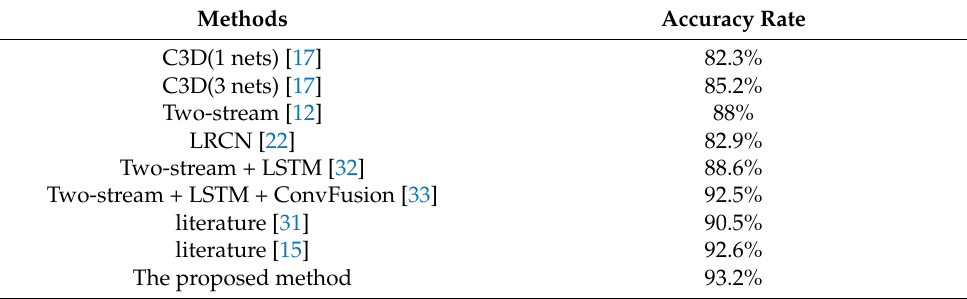
Table 8. The experiment comparison results on the